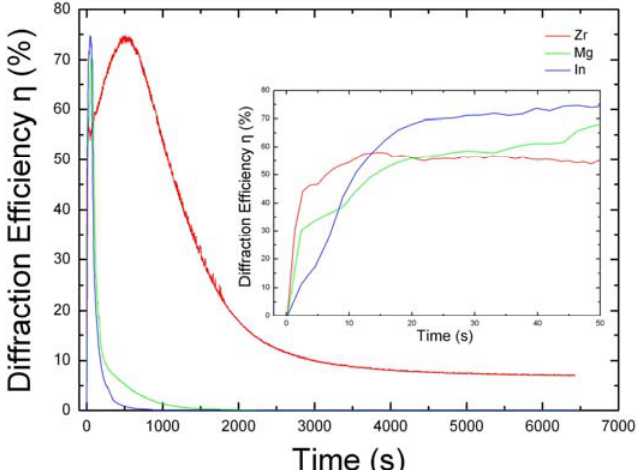
Figure 5. Holographic Recording and Fixing Characteristics of LN:Zr,Fe,Mn, LN:Mg,Fe,Mn and LN:In,Fe,Mn. Recording time is 50 s. Readout time is more than 100 min. The inset shows the recording process (0 s to 50